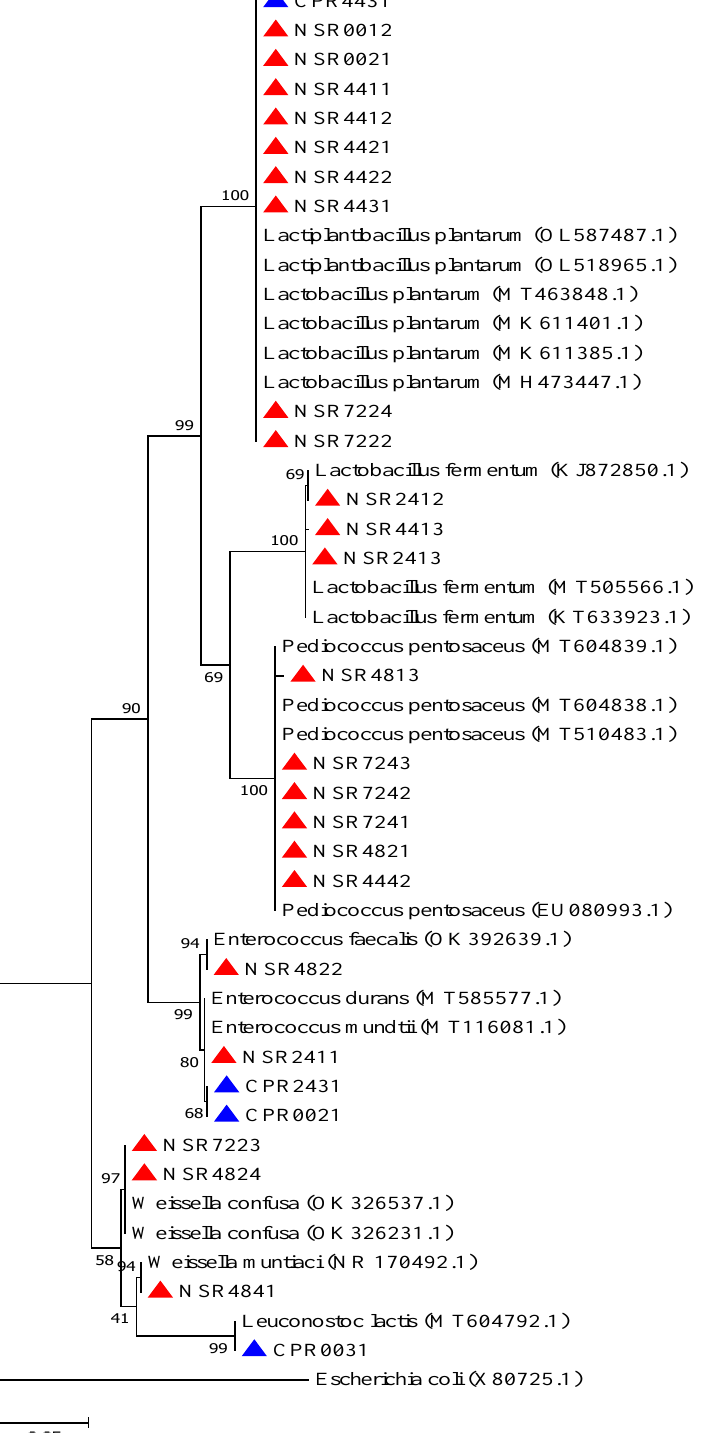
Figure 7 . A phylogenetic tree based on 16S rRNA gene sequences shows the relationship between lactic acid bacteria isolated from nightshade/cowpea leaves and representatives of other related taxa. The scale bar indicates 0.05 substitutions per nucleotide position. The red arrows indicate isolates from nightshade and blue arrows indicate isolates from cowpea. The number beside the node is the statistical bootstrap value. In brackets are the GenBank accession numbers. The gene sequence of E. coli (X80725.1) was used as an